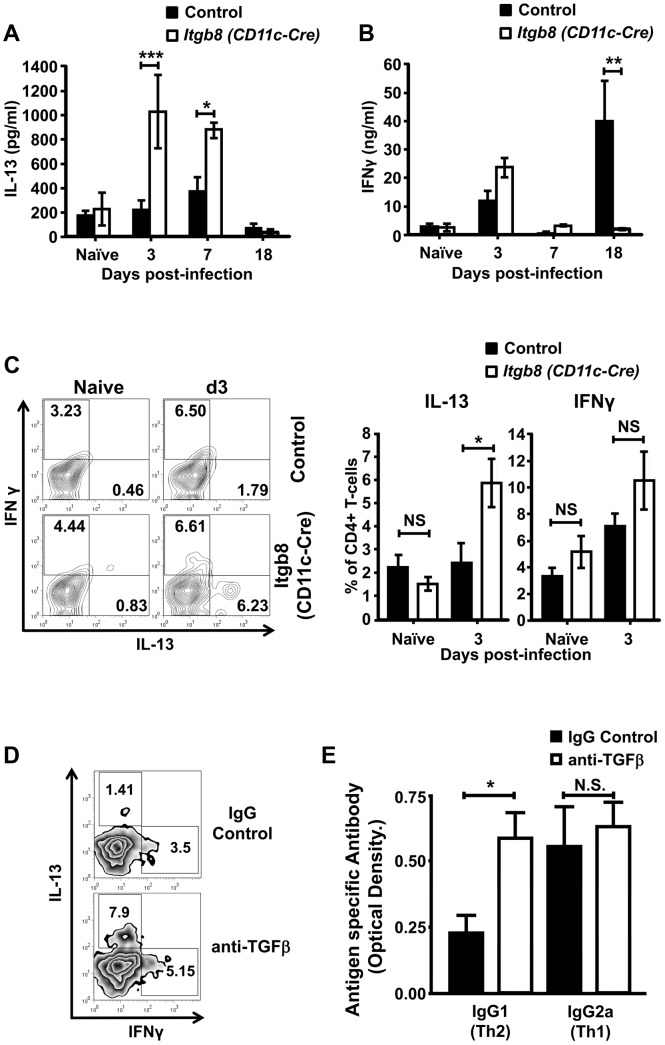
Mice lacking the TGFβ-activating integrin αvβ8 on DCs demonstrate an enhanced IL-13 production in LILP CD4+ T-cells.(A) IL-13 and (B) IFNγ cytokine levels from T. muris E/S antigen-stimulated mLN cells from control and Itgb8 (CD11c-Cre) mice at different time-points post-infection ( p.i.) with a chronic dose of T. muris eggs, determined via cytometric bead array/ELISA. Data (n = 5–6 mice per group) are from three or more independent experiments. (C) Analysis of intracellular IL-13 and IFNγ expression in CD4+ T-cells isolated from control and Itgb8 (CD11c-Cre) mice at day 3 p.i. with a chronic dose of T. muris eggs. Representative flow cytometry plots and mean data are displayed. Data (n = 5–6 mice per group mice per group) are from three independent experiments. (D) Representative flow cytometry plots for IL-13 and IFNγ from LILP CD4+ T-cells at day 3 p.i. and (E) Serum antigen specific IgG1 and IgG2a levels at day 21–23 p.i. from control and anti-TGFβ antibody-treated C57BL/6 mice infected with a chronic dose of T. muris eggs. Data (n = 7–9 mice per group) are from two independent experiments performed. *, P<0.05; **, P<0.01; or ***, P<0.005, N.S., not significant via Kruskal–Wallis (A and B) and Student's t-test (C and E) for the indicated comparisons between groups, error bars represent SE of means.